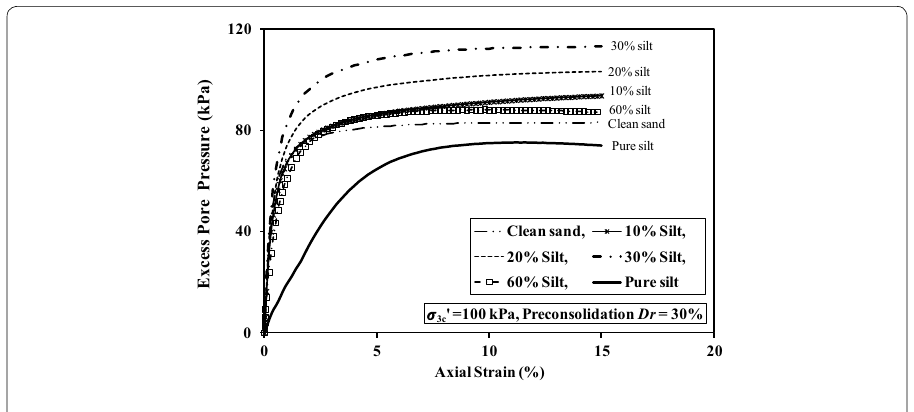
Fig. 10 Excess pore pressure versus strain curve at 30% relative density